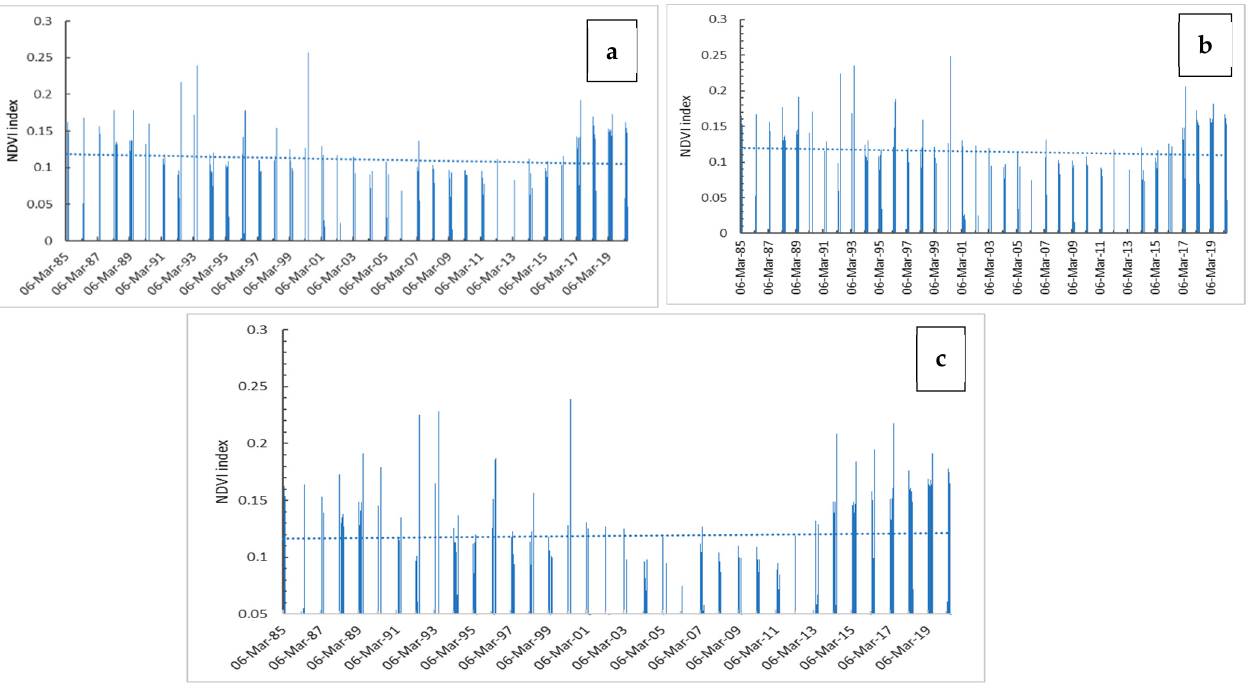
Figure 6. Riparian vegetation cover change analysis using NDVI for ( a ) 30 m buffer distance of the river Channel Gumara, ( b ) 60 m buffer distance, and ( c ) 90 m buffer distance.